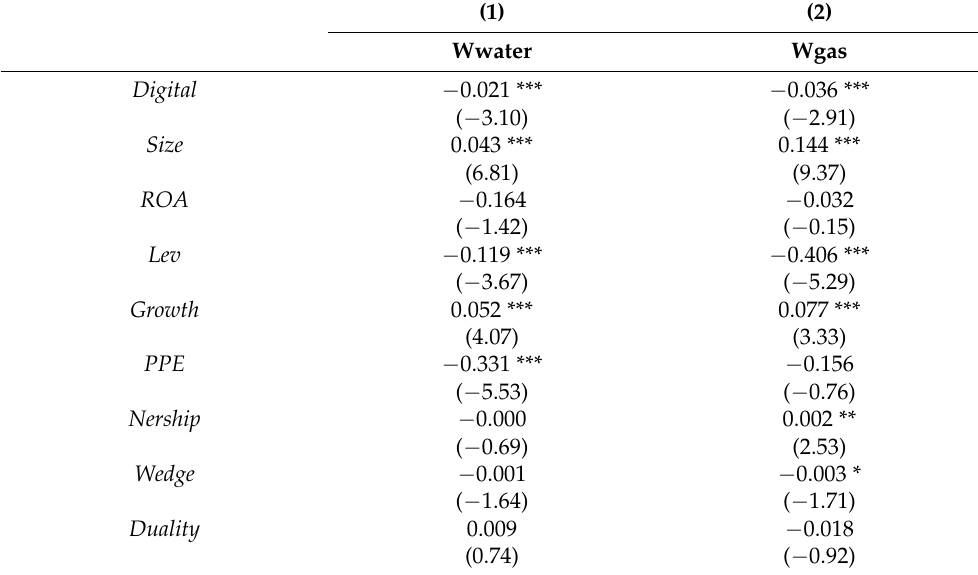
Table 3. Robust check: different model. This table reports the results of OLS regressions examining the effect of digital transformation on environmental pollution. Appendix A provides variable definitions. The regressions control for the interaction term of industry and year fixed effects. In parentheses are t -statistics based on standard errors adjusted for heteroskedasticity and firm